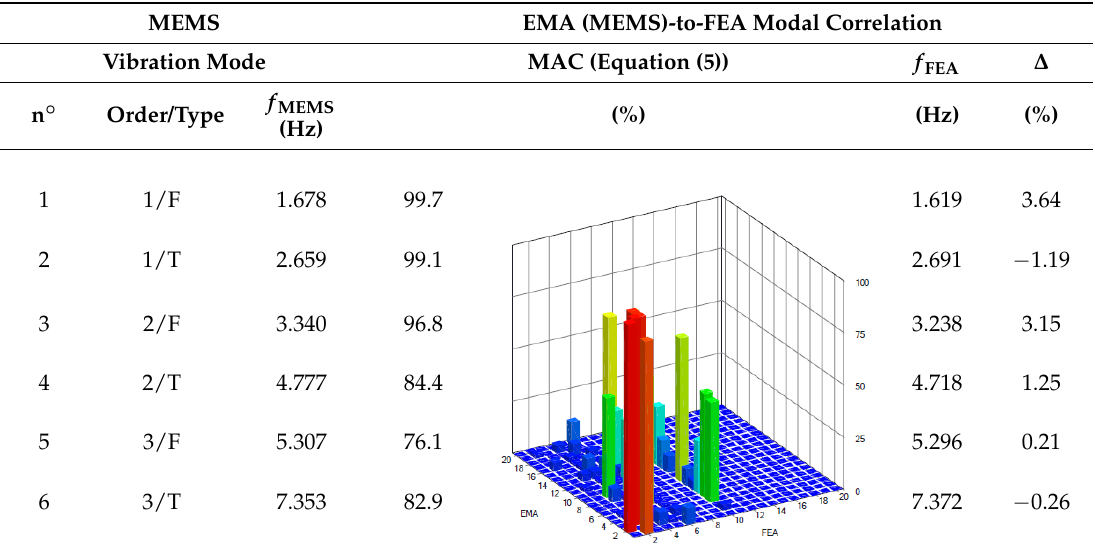
Table 4. EMA (MEMS) vibration frequencies, and correlation with past FEA results [44]. Key: F